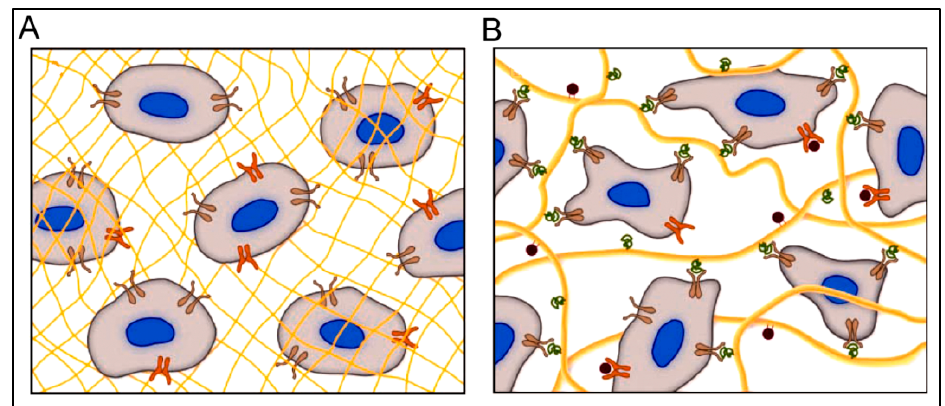
Figure 3. A hydrogel matrix composed of ( A ) synthetic polymers (yellow mesh) provides a 3D environment for culturing cells; however, they fail to activate integrins (brown) and other surface receptors (orange), and ( B ) formed from naturally derived polymers present a myriad of integrin-binding sites (green) and growth factors (red) coordinated to the ECM (yellow fibers). Reprinted with permission from Ref. [174]; Copyright 2009, Wiley-VCH.